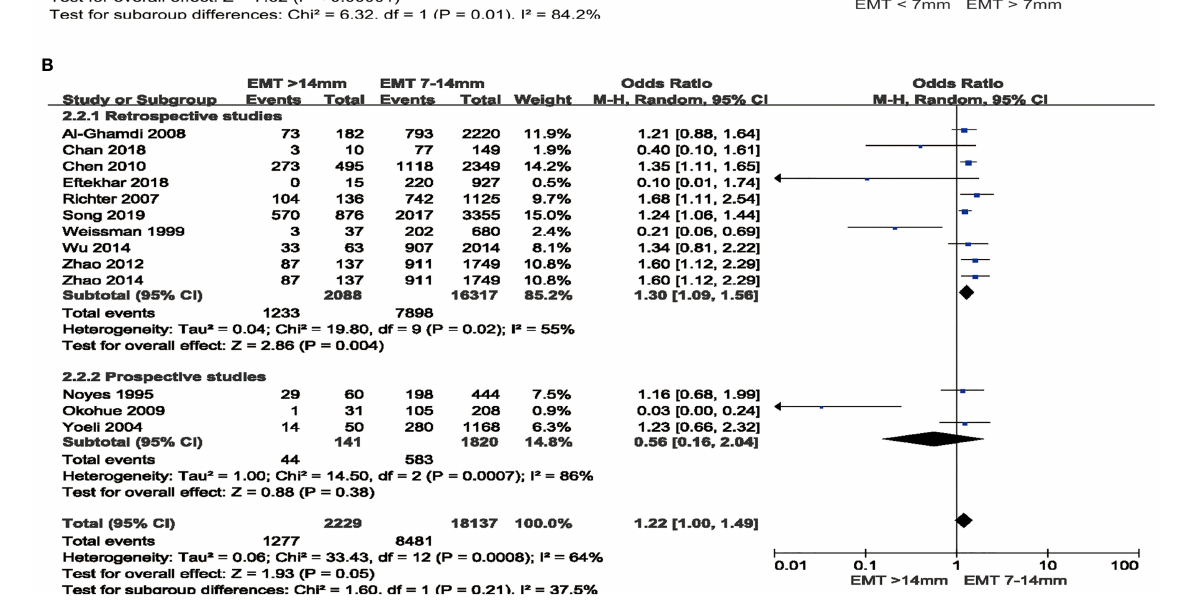
kg, 95%CI: − 0.19, − 0.04, P = 0.004, no heterogeneity I 2 = 0%). No